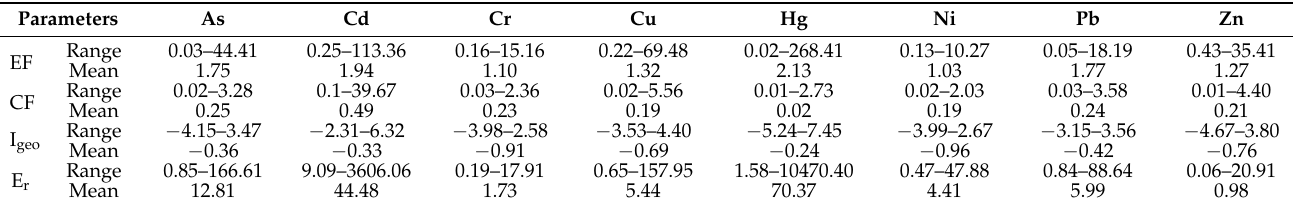
Table 7. Enrichment factor (EF), contamination factor (CF), geo-accumulation index (I geo ) and potential ecological risk index (Er) values of heavy metals in study